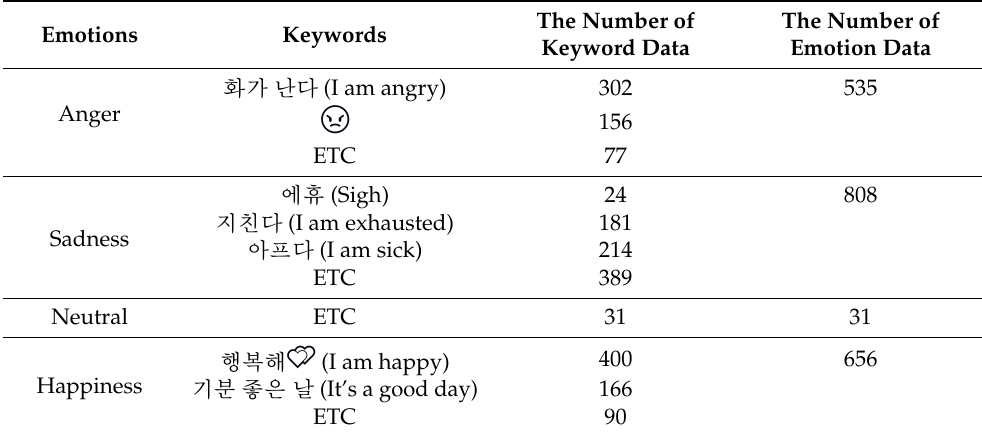
Table 1. Dataset distribution of Instagram-crawling.